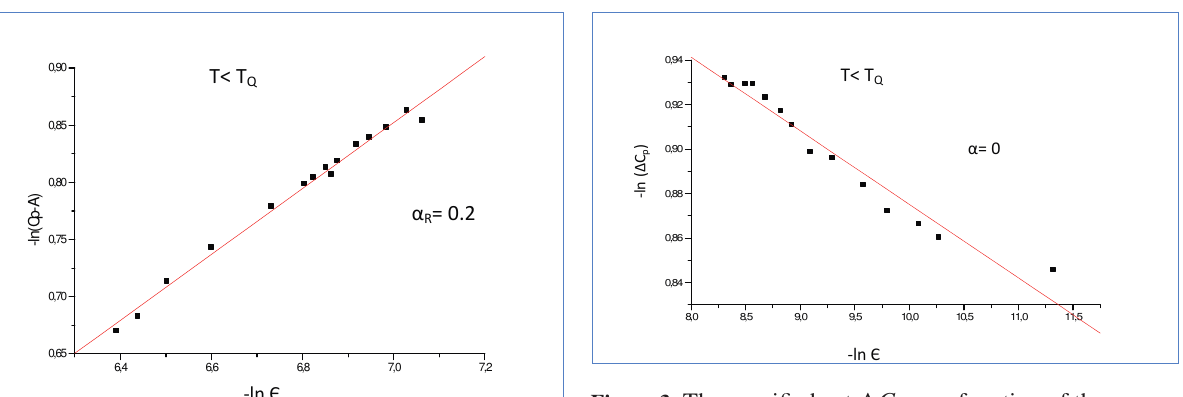
Figure 3. The specific heat (cid:3)C p as a function of the re- duced temperature ( (cid:4) D j T (cid:2) T Q j =T Q ) below the transition temperature ( T Q D 578 ı C) for the ˛ - ˇ phase transition in quartz according to Eq. (2).